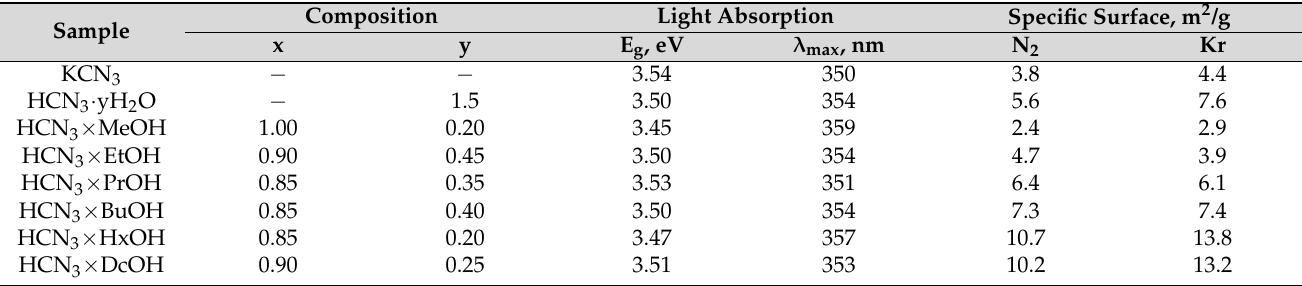
Table 1. Quantitative compositions, light absorption regions, and specific surface areas of the samples. The compositions are presented in the form x(RO)H 1 − x Ca 2 Nb 3 O 10 − x · yH 2